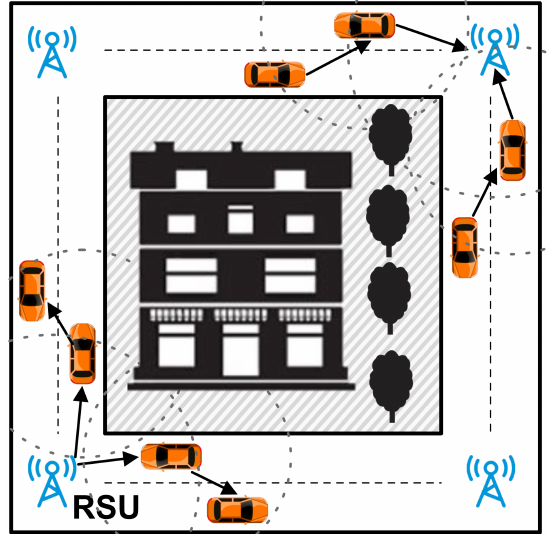
Figure 4. Scenario 1: data communications in one road